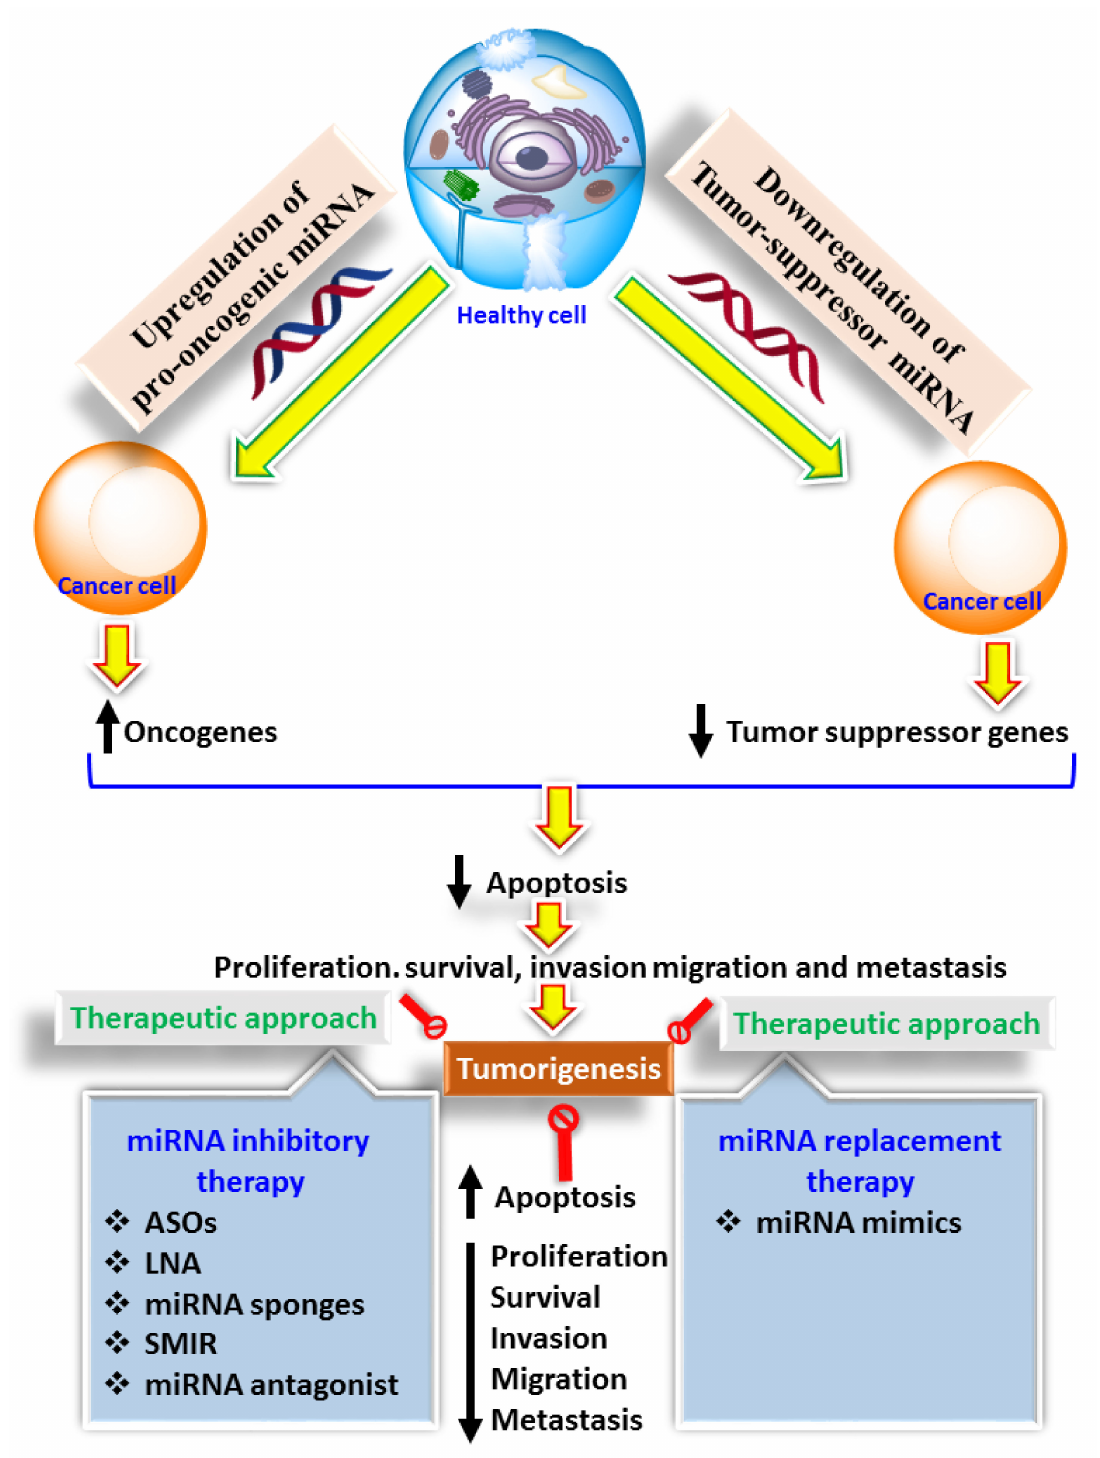
Figure 2. Showing the immunotherapeutic approach of miRNA in